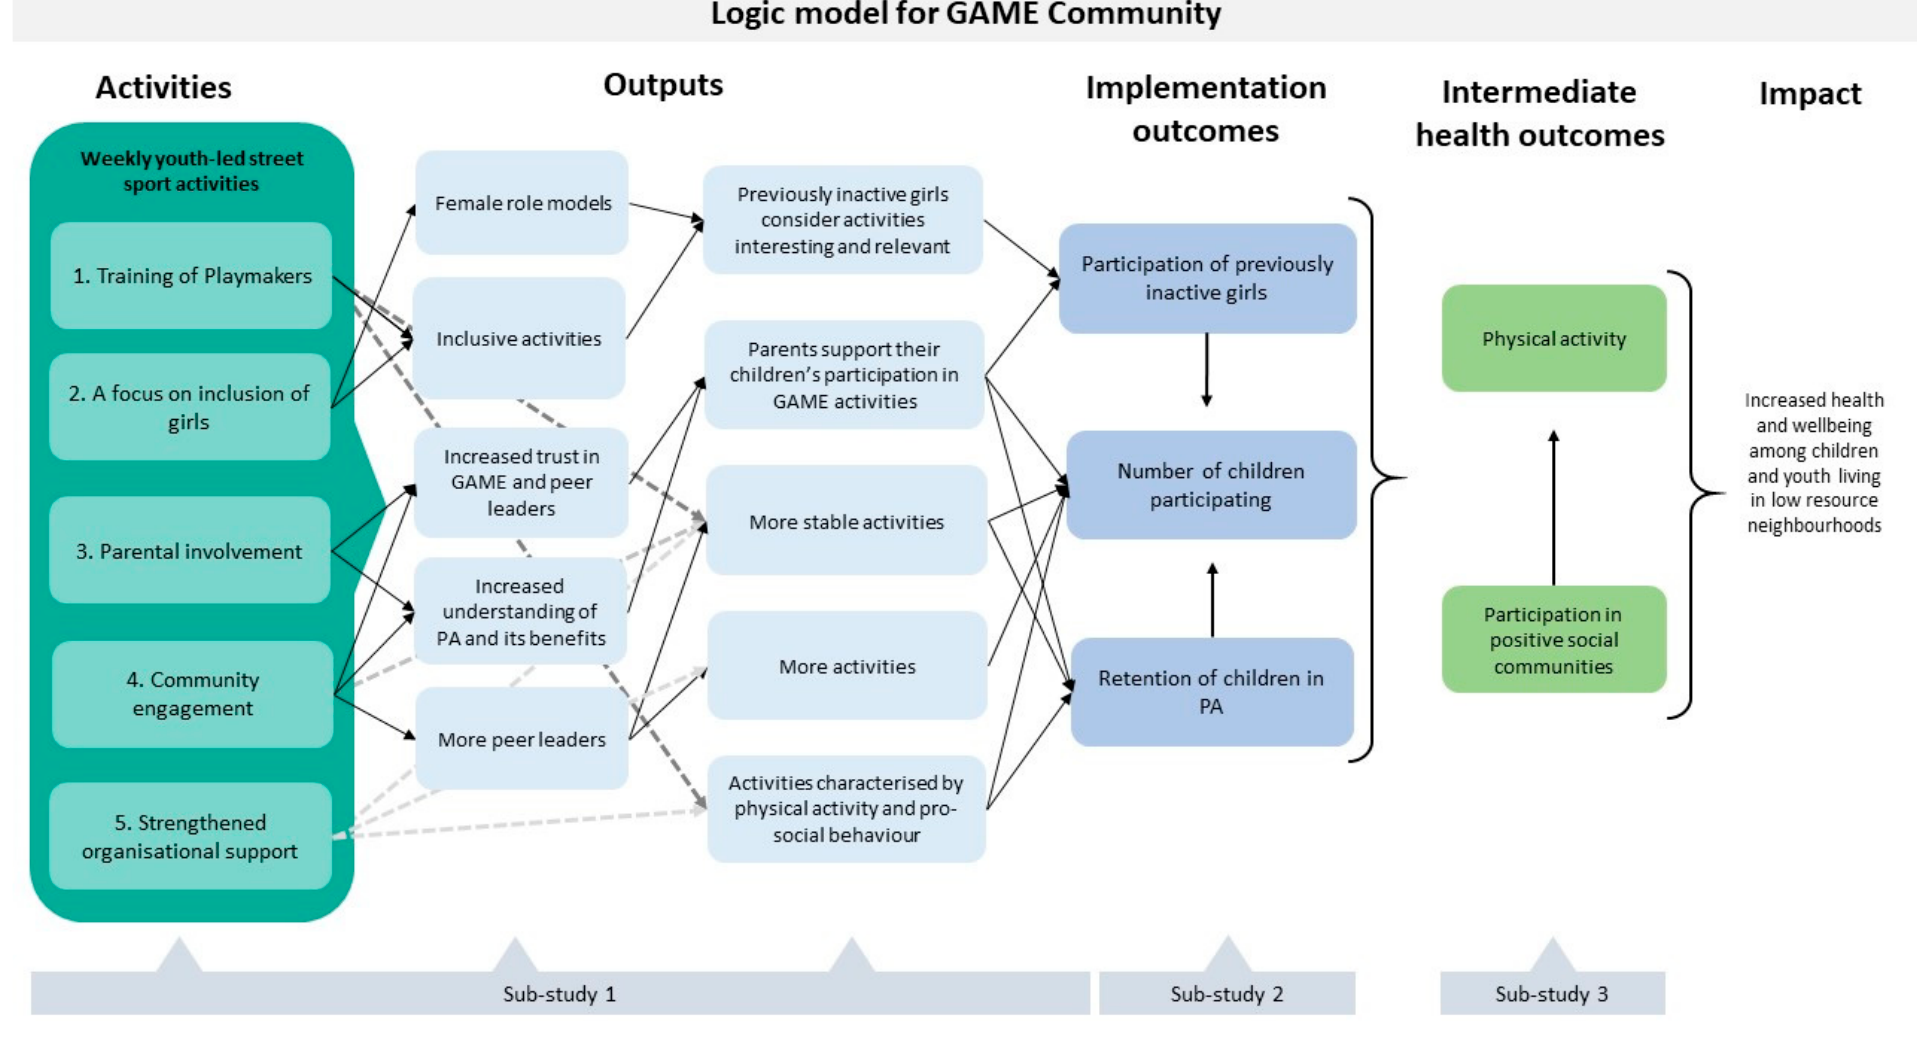
Figure 1. Logic model for the GAME Community